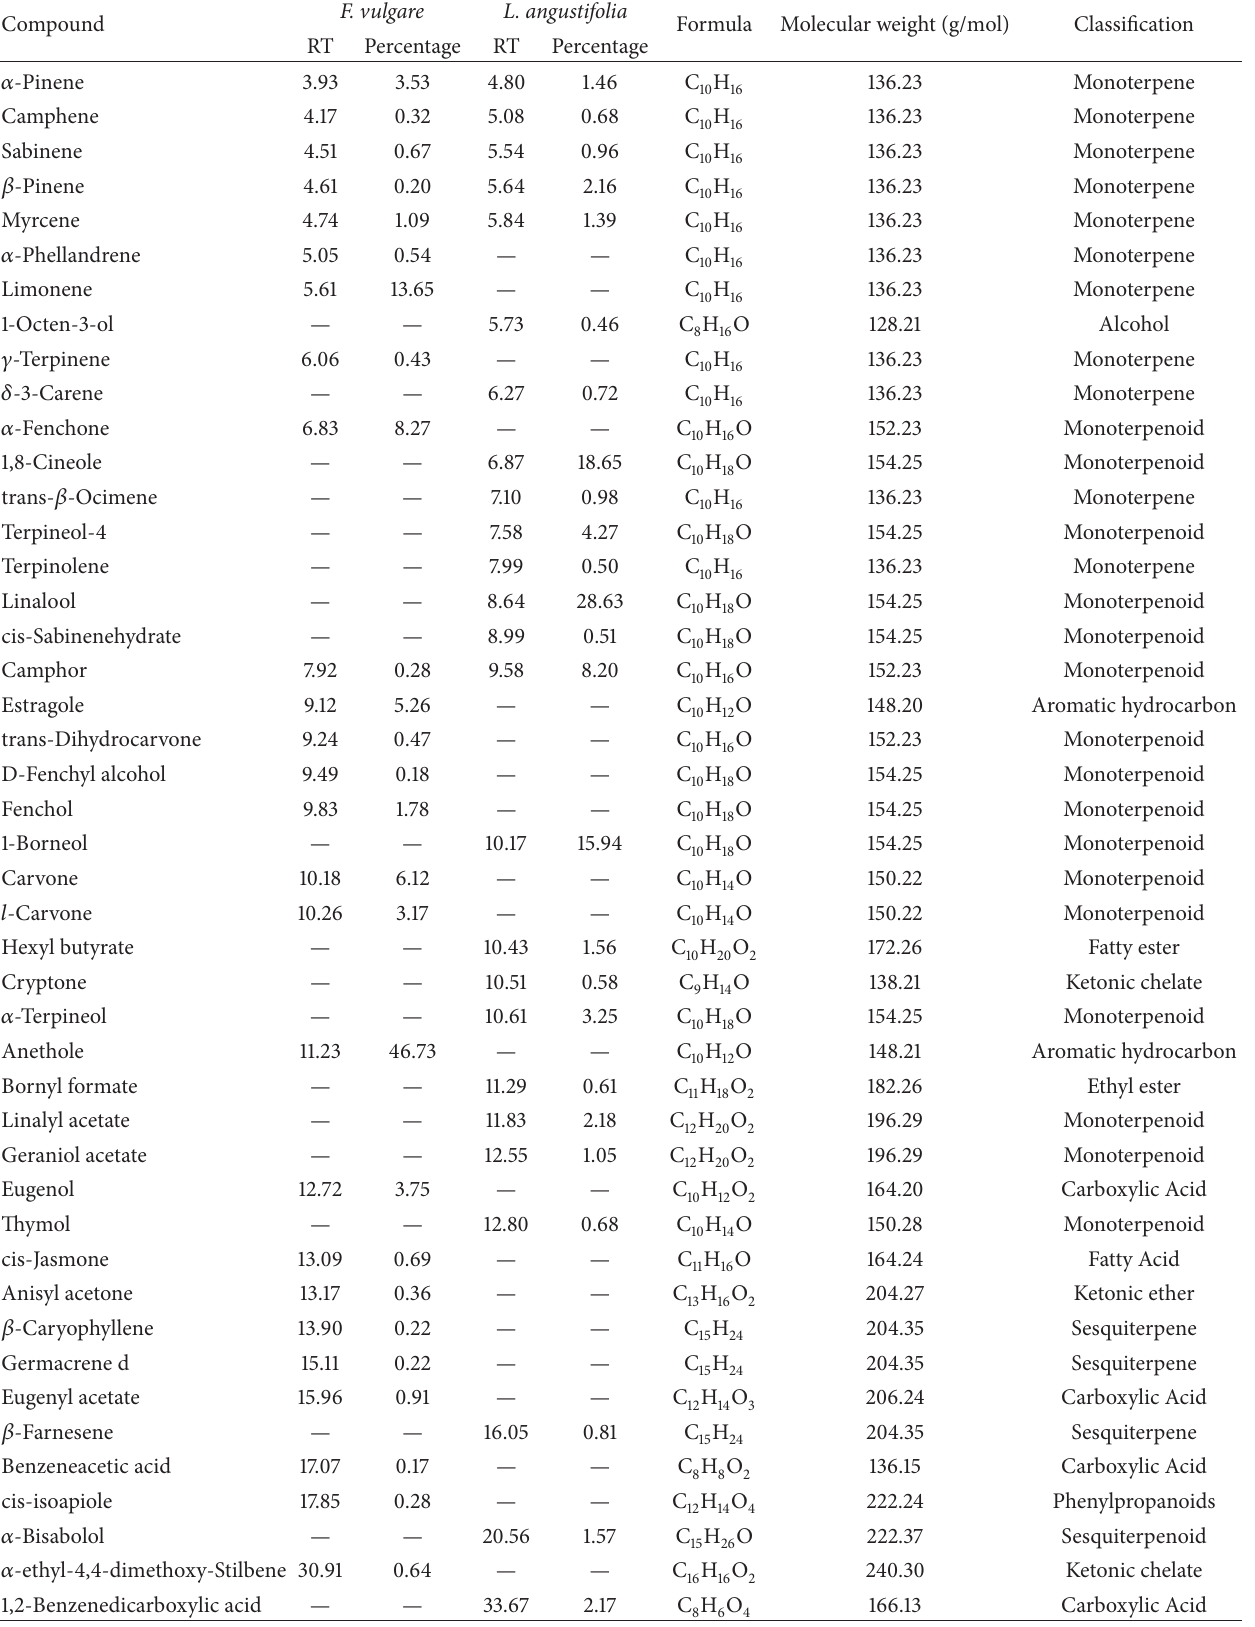
Table 1: Chemical analysis of essential oils of Foeniculum vulgare and Lavandula angustifolia grown in Iran by GC-MS.